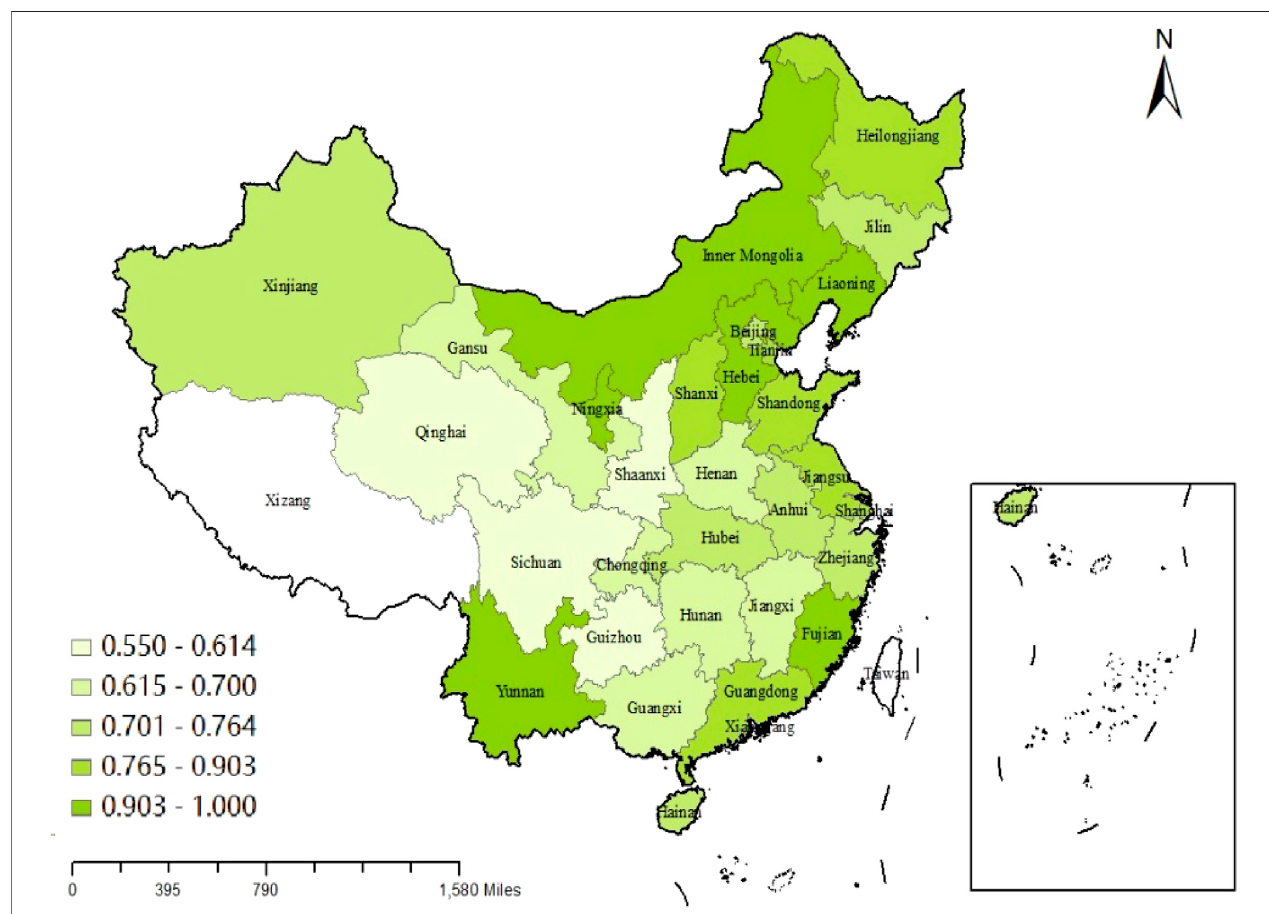
FIGURE 5 | Average annual technical ef fi ciency in various regions.